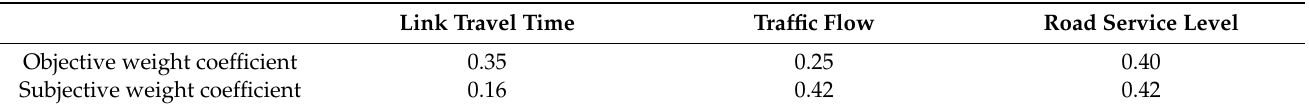
Table 9. Combined weighting coefficient of FCSs .